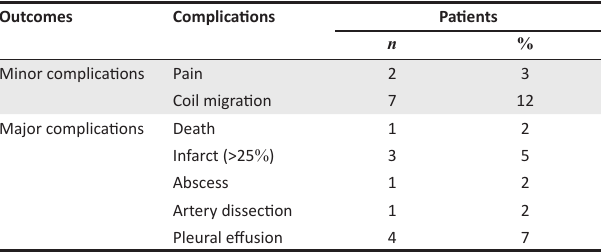
TABLE 3: Outcomes of splenic artery